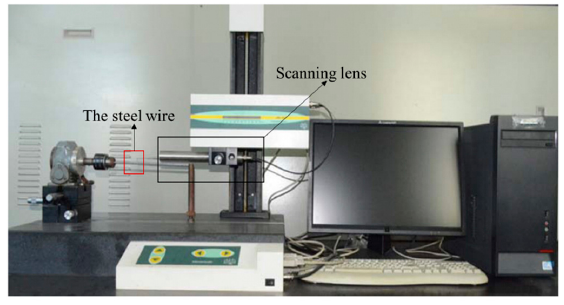
Figure 4. Non-contact 3D scanner.